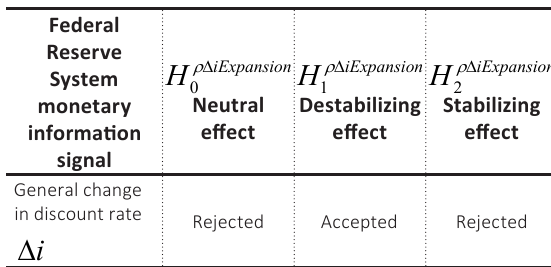
Table 12. Testing results for